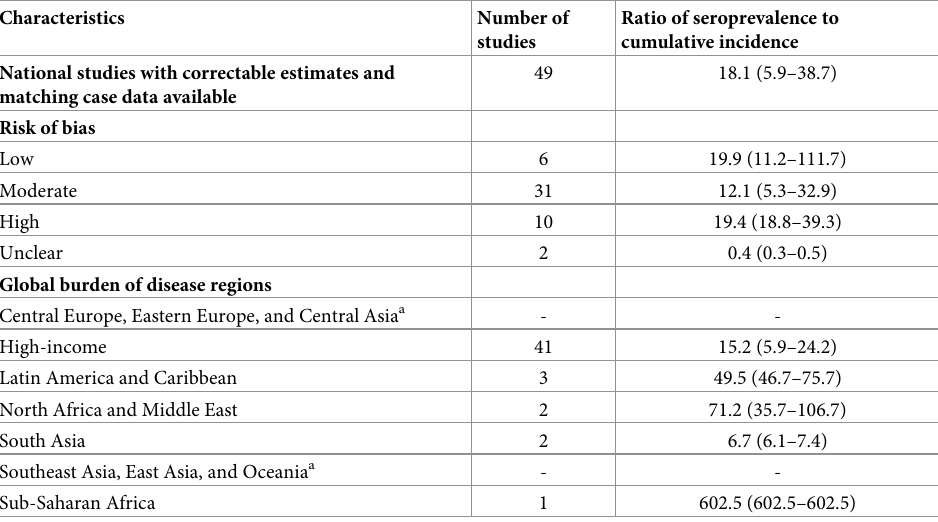
Ratio of seroprevalence to studies cumulative incidence